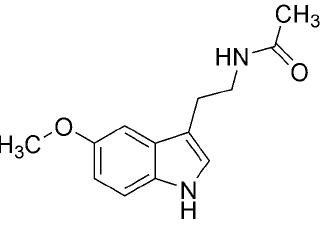
Figure 1. Structure of melatonin (MLT).